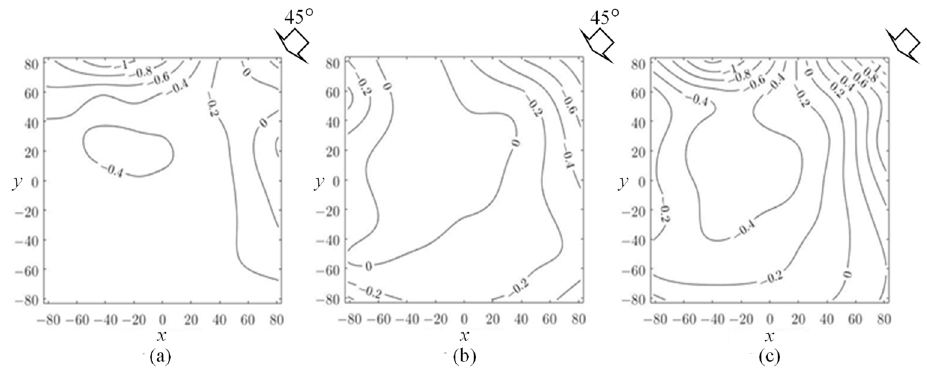
Figure 6. Contours of mean wind pressure and force coefficients at θ = 45 ◦ : ( a ) C pt , ( b ) C pb , ( c ) C f .